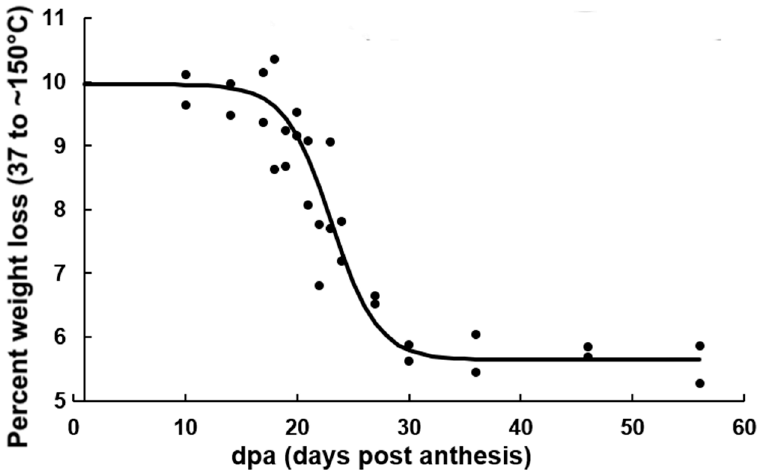
Figure 6. Evolution of the weight loss percent in the region from 37 to 150 °C as a function of dpa for TM-1 genotype.